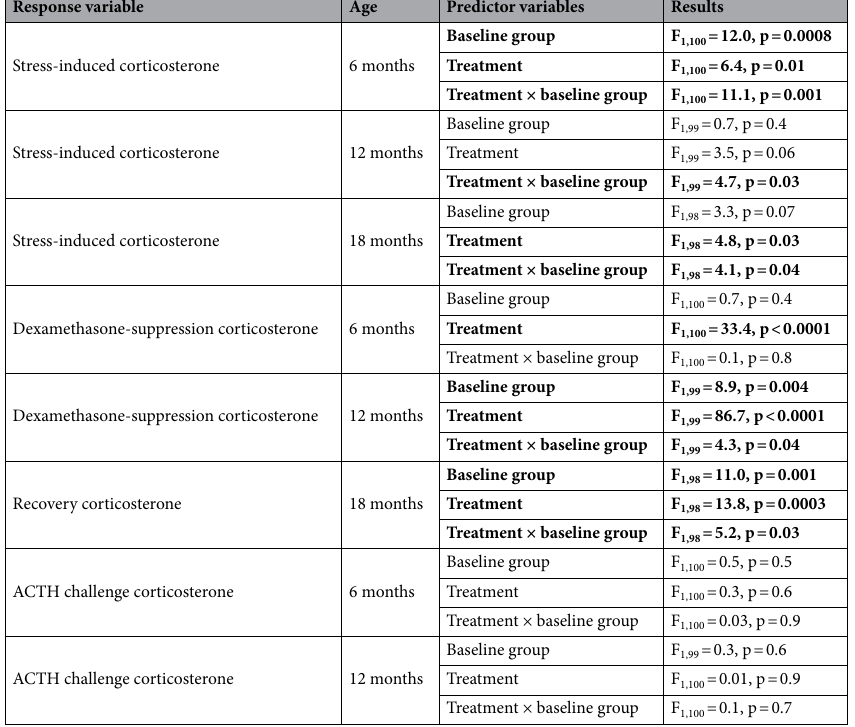
Table 3. Results of generalized linear mixed models (GLMM) analyzing the response to treatment (control or 5 ng corticosterone), baseline corticosterone group, and their interaction on corticosterone concentrations at different timepoints in the stress series. Bold values indicate p <